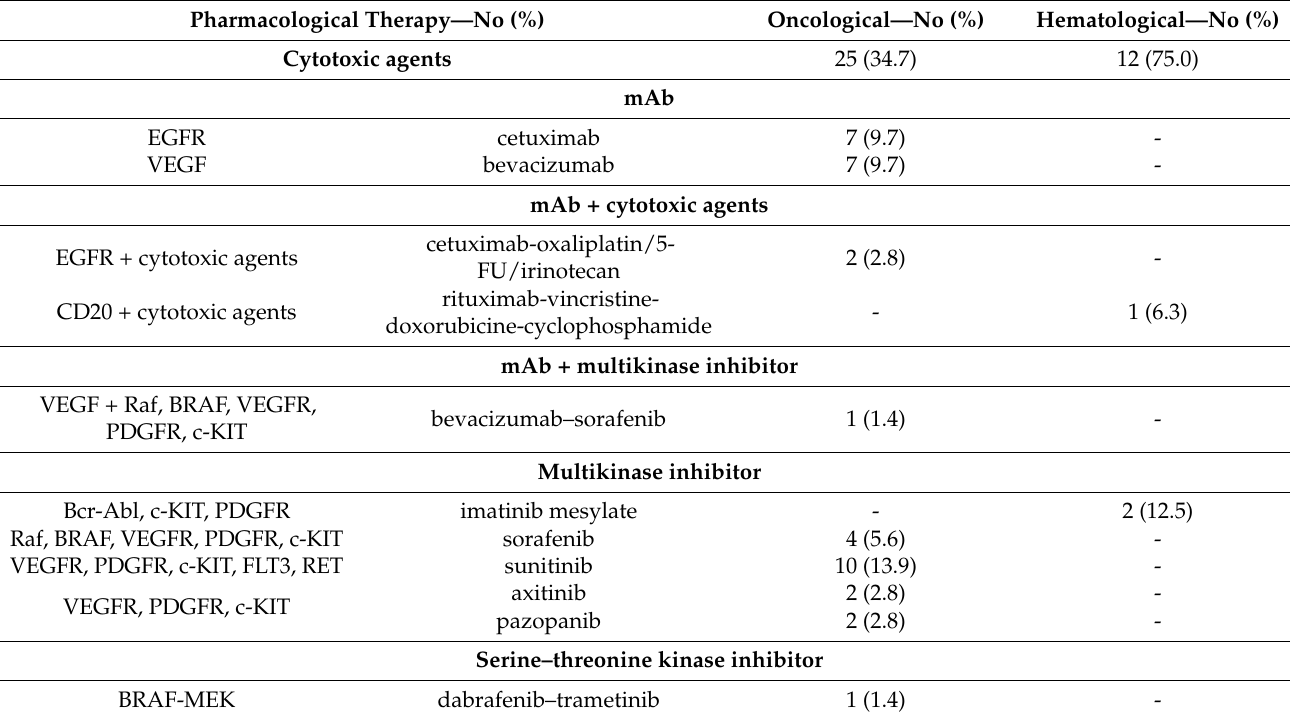
Table 2. Pharmacological therapy suspected of causing PI.